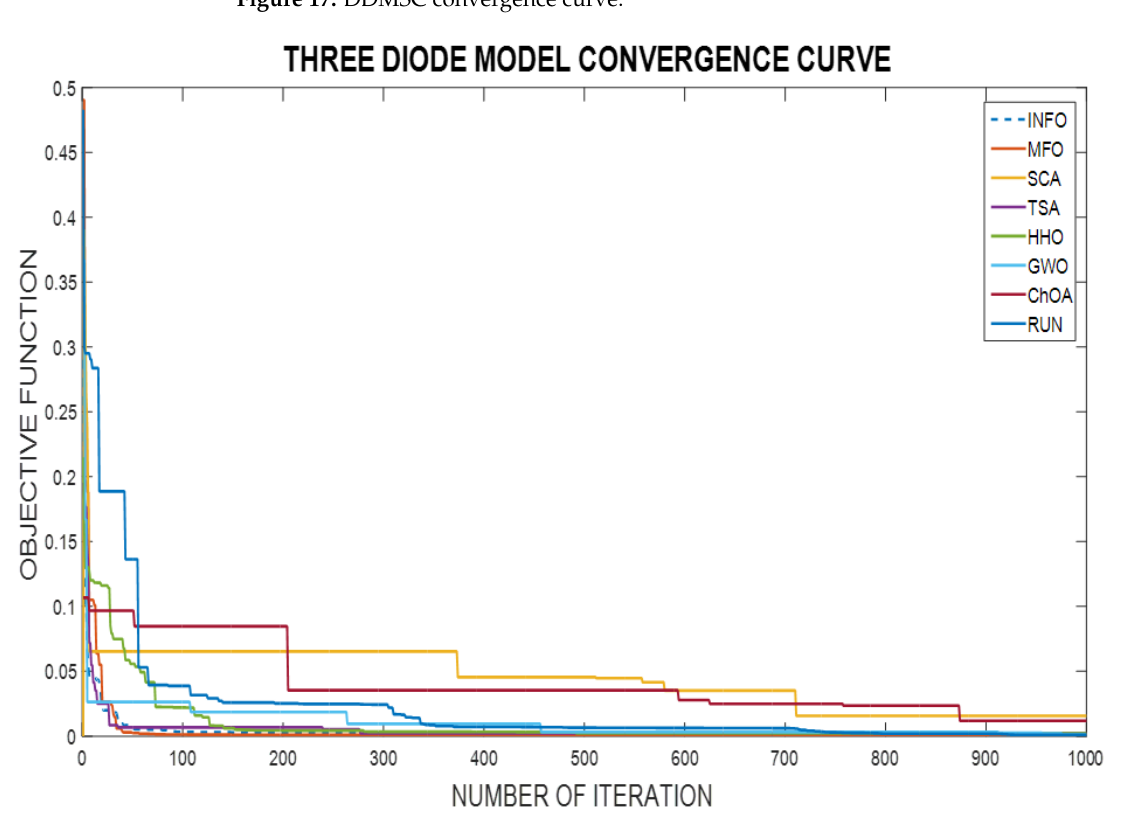
Figure 17. DDMSC convergence curve.